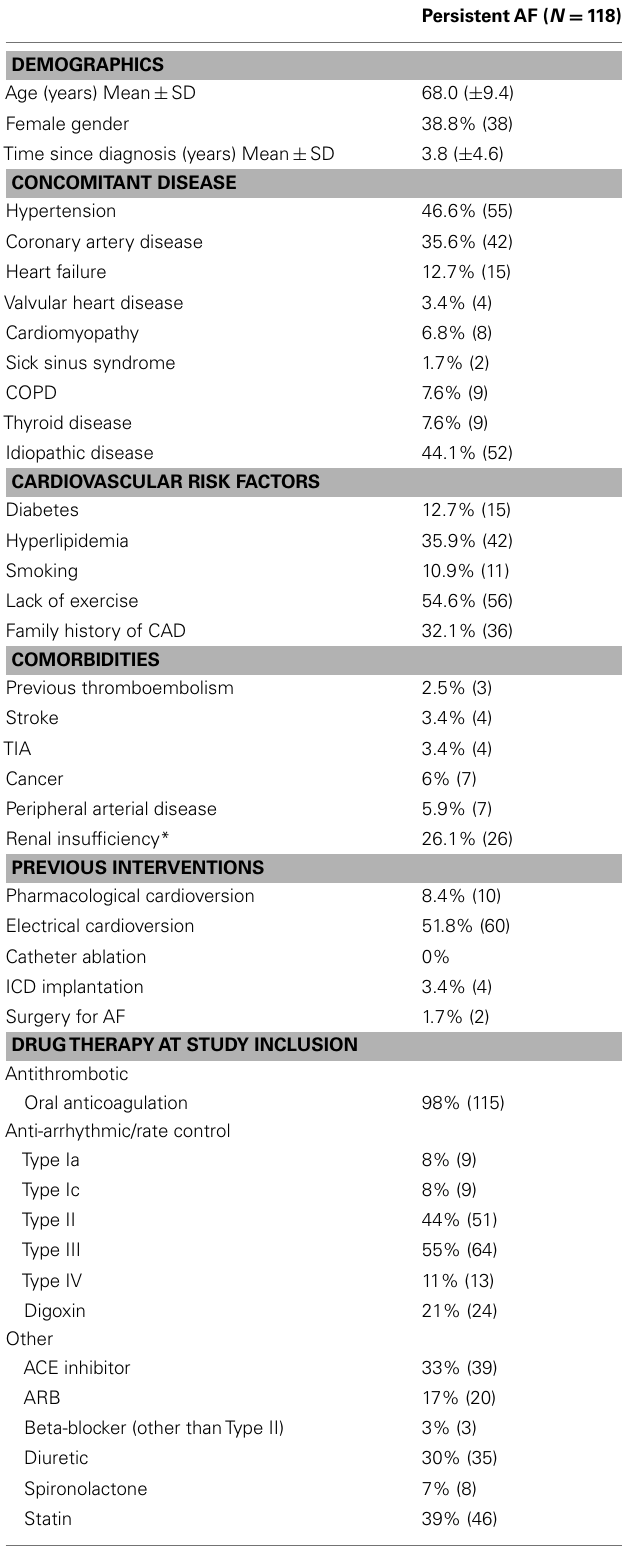
Table 1 | Patient